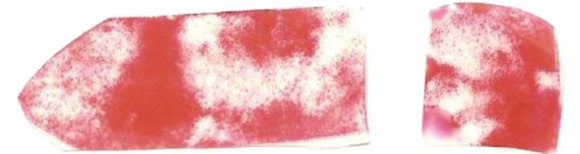
Figure 5: Pressure sensitive films. Bigger one is from radioscaphoid and the smaller one is from scaphocapitate joint.